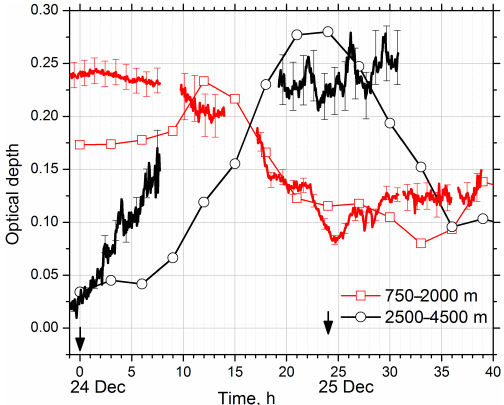
Figure 14. Aerosol optical depth at 355nm on 23–24 December 2015 obtained from MERRA-2 (line + symbols) and from the Ra- man lidar measurements (solid lines). The results are given for two height intervals: 750–2000m (red) and 2500–4500m (black). Zero of timescale corresponds to 00:00UTC on 24